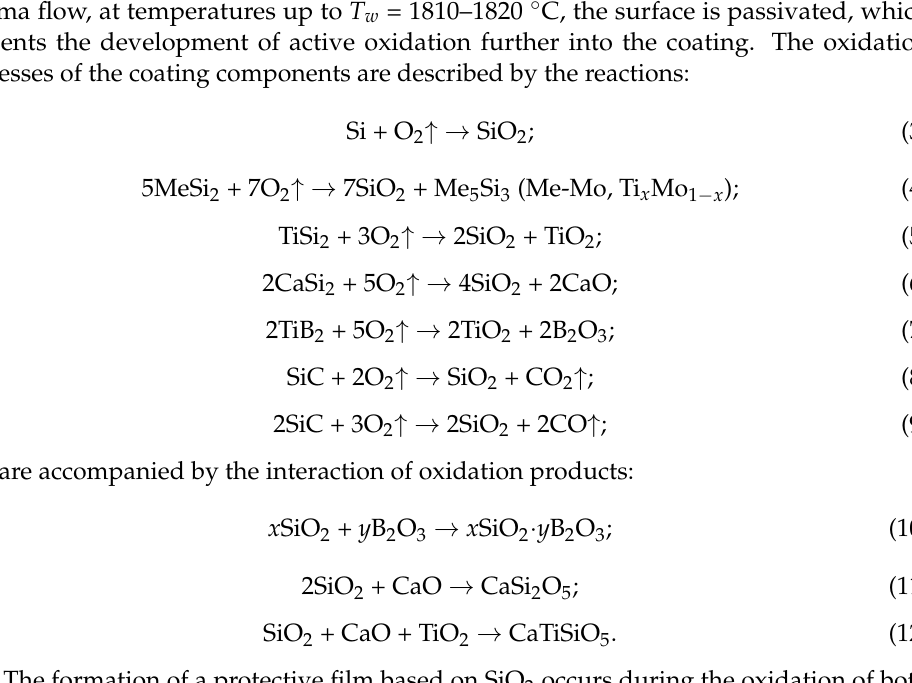
Figure 12. The microstructure of the surface of the oxide film on the Si–TiSi 2 –MoSi 2 –TiB 2 –CaSi 2 coating after gas-dynamic tests according to the regime shown in Figure 4 а : ( а ) х 4000; ( b ) х 30000.